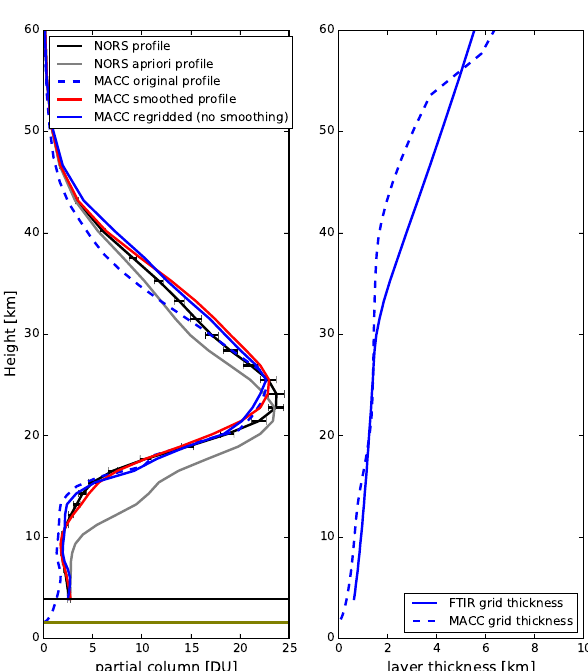
Figure 4. Example of a model O 3 partial column profile (dashed blue) and FTIR measured profile (black). The model profile is first re-gridded to the measurement grid (blue) and smoothed (red) at Jungfraujoch. The lower two horizontal lines show the lowest layer height of the model (lowest) and site (highest). Because a partial column profile depends linearly on the layer thickness of the grid, the right plot shows the layer thickness profile for model and mea- surement grids. Above 40km the measurement (black), a priori (gray) and smoothed model (red) profiles coincide because the sen- sitivity of the measurement decreases (see Fig. 5).